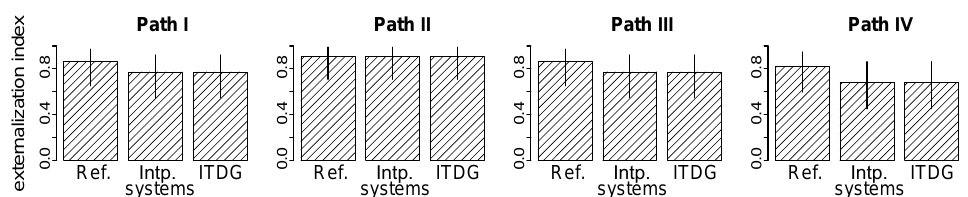
Figure 14. Externalization indices for the systems and paths with 95% binomial confidence intervals; Ref.: reference, ITDG: initial time delay gap, Intp.: interpolation (data from the work in